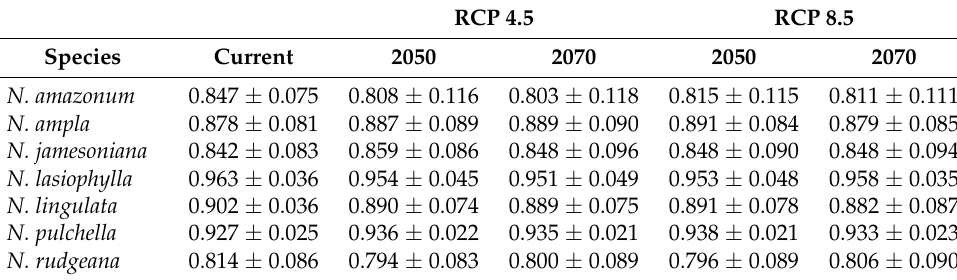
Table 3. The area under the curve (AUC) and standard deviation values for the seven Nymphaea species distribution models in two representative concentration pathways (RCPs 4.5 and 8.5) and two scenarios (2050 and